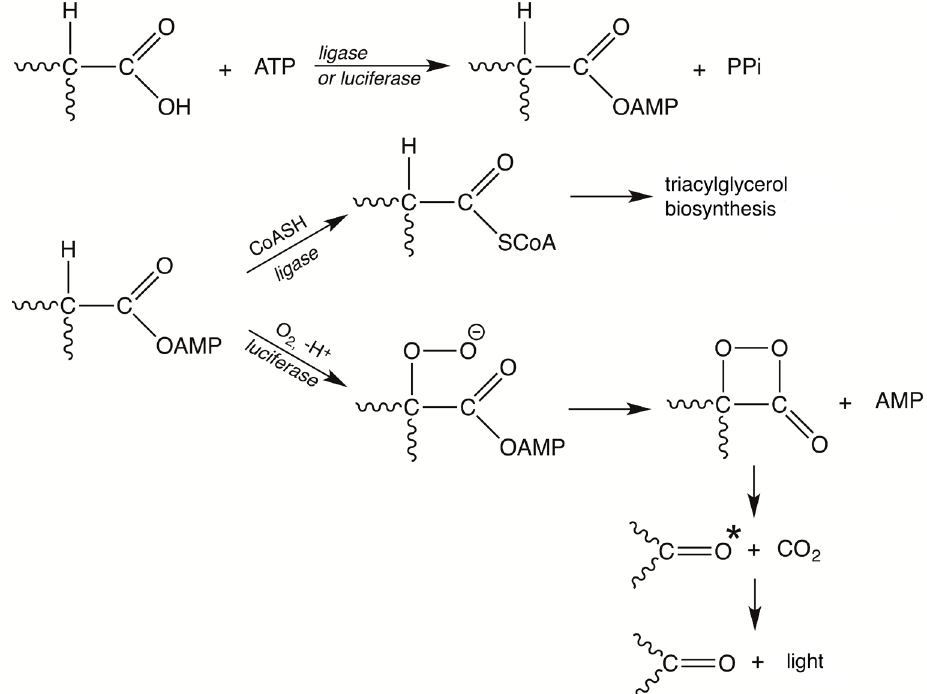
Figure 9 - The putative ligase origin of firefly luciferase. Ligases (ATP-synthetases) catalyze the adenylation of carboxylic metabolites (RCOOH) making reactive mixed anhydride intermediates (RCOOAMP) in microorganisms, mammals and plants. RCOOAMP intermediates are converted by coenzyme A (CoA-SH) into thioesters (R-CSCoA), which are attacked by glycerol to form acylglycerols (fatty acids derivatives) in fats, oils and membrane phospholipids. Conversely, the luciferin adenylate adds molecular oxygen to yield sequentially luciferin hydroperoxide, dioxetanone and electronically excited oxyluciferin, which collapses to the ground state by cold light emission (Fig.